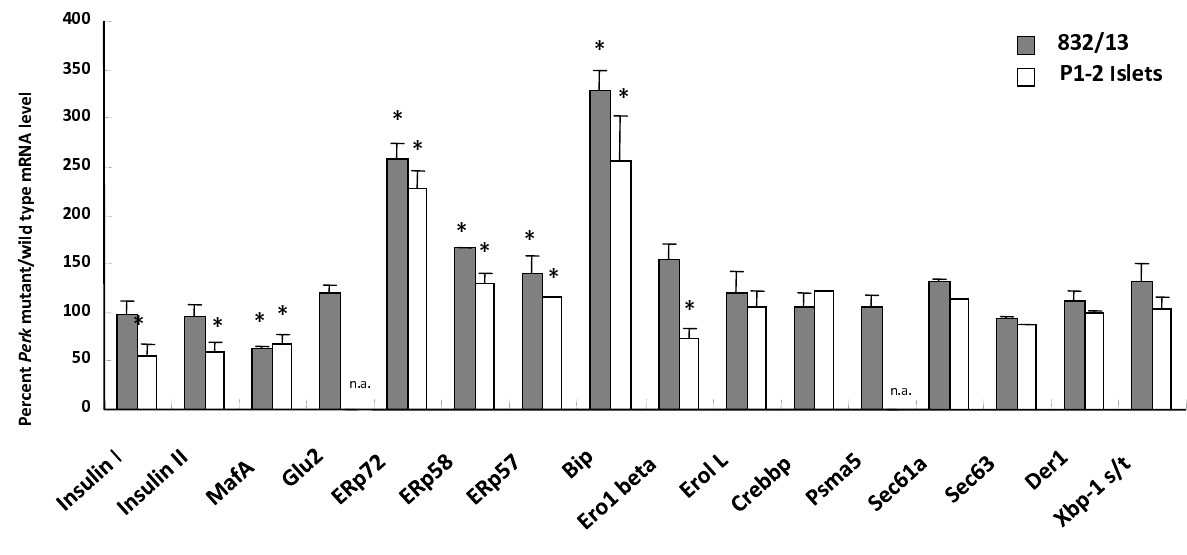
Figure 6 Comparison of gene expression in Perk deficient islets and 832/13 transformed beta cells . The expression of mRNAs in Perk -/- islets and AdDNPerk 832/13 beta cells were normalized to Perk +/+ islets and AdLacZ 832/13 beta cells, respec- tively. For the 832/13 cells a low dose of adenovirus (MOI = 5) was used, and the data from 2 to 5 independent experiments were analyzed. For islets, mRNA expression was also quantified from 5-9 WT and 4-9 Perk KO mice. For Xbp-1 the spliced Xpb-1 mRNA form was normalized to total Xbp-1 mRNA. Not assayed for specific mRNAs denoted as